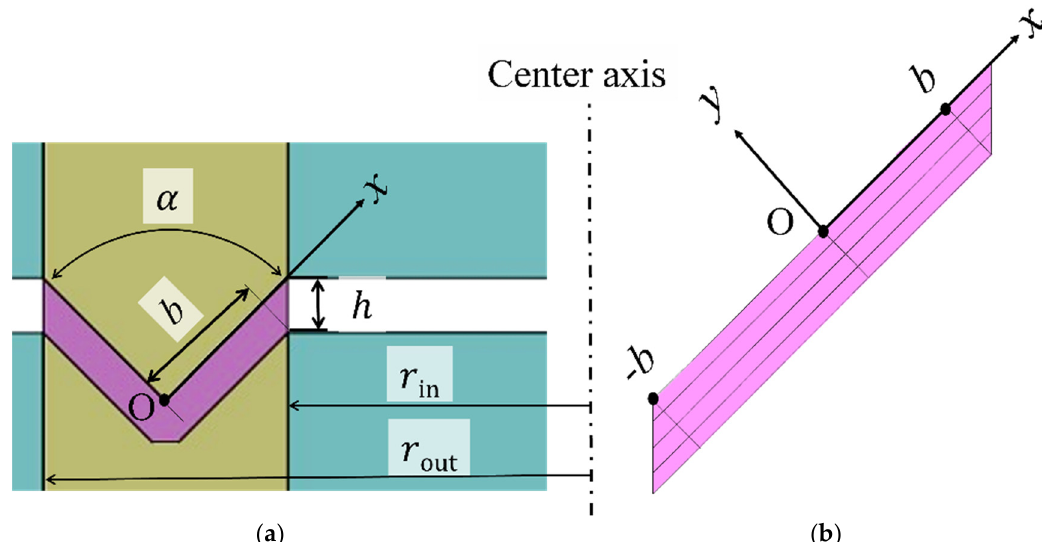
Figure 14. Definition of integration area for V-shaped plate . ( a ) Parameters, ( b ) integration area after turnback.